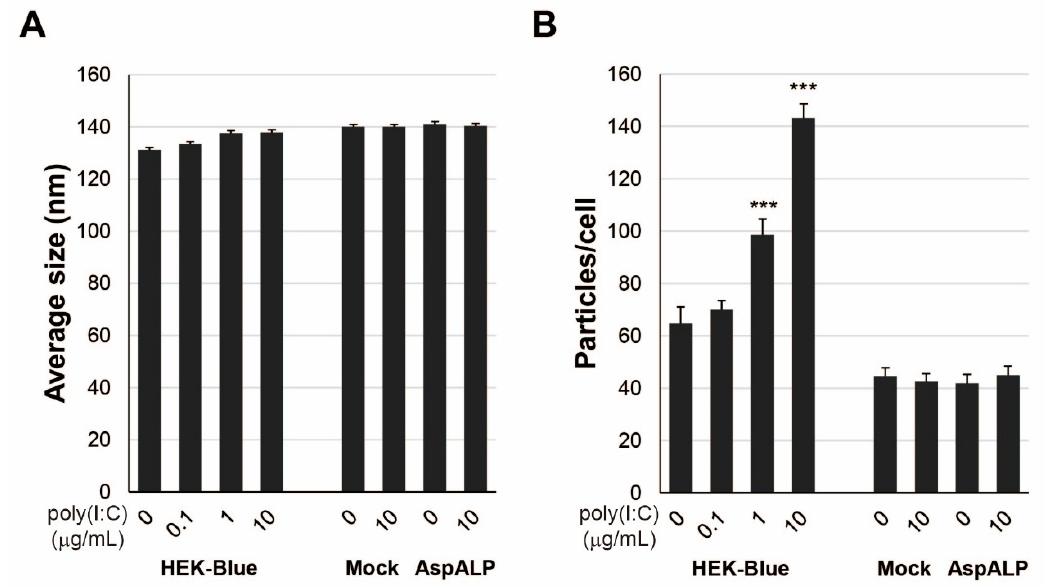
Figure 4. Properties of exosomes released from poly(I:C)-stimulated cells. ( A ) The average size of exosomes released from poly(I:C)-stimulated HEK-Blue hTLR3, T-REx Mock and T-REx AspALP cells. ( B ) Released exosomes per cell. *** p < 0.001 vs. cells in the absence of poly(I:C).